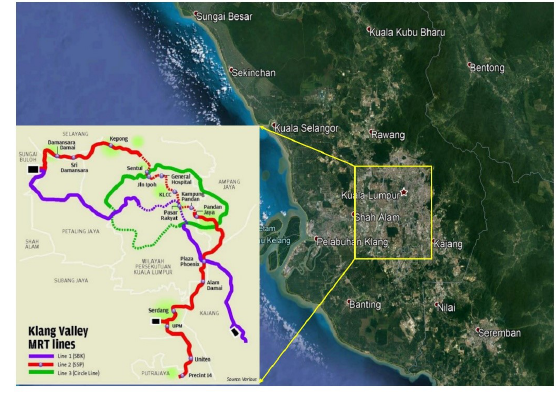
Fig. 1. Location of the KVMRT